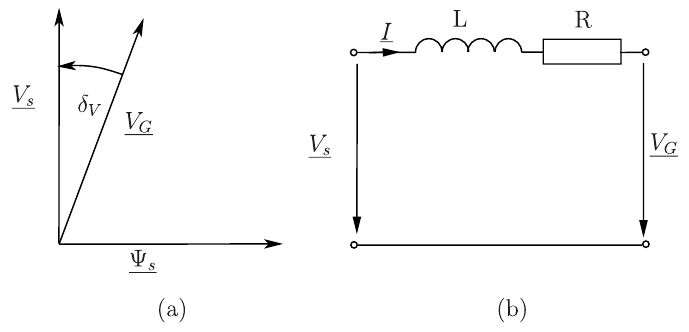
Figure 4. ( a ) Equivalent circuit. ( b ) Phasor